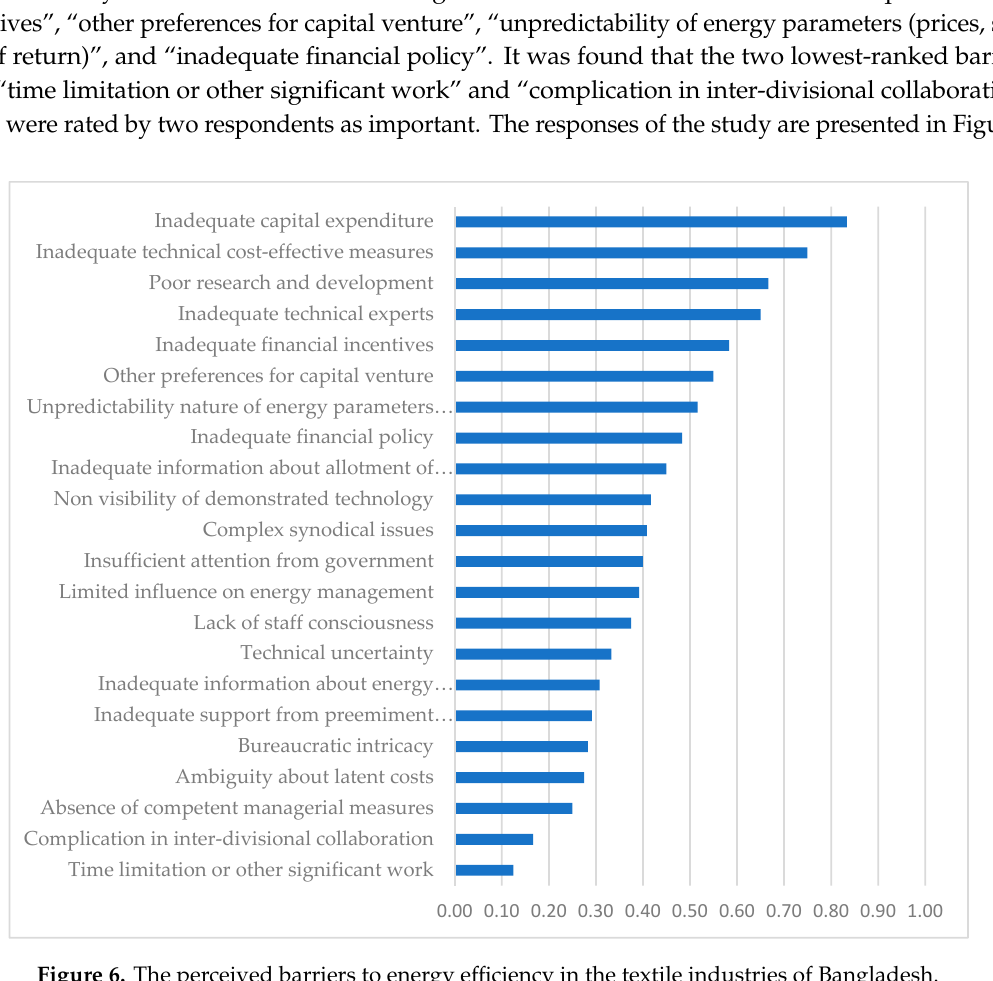
Figure 6. The perceived barriers to energy efficiency in the textile industries of Bangladesh.